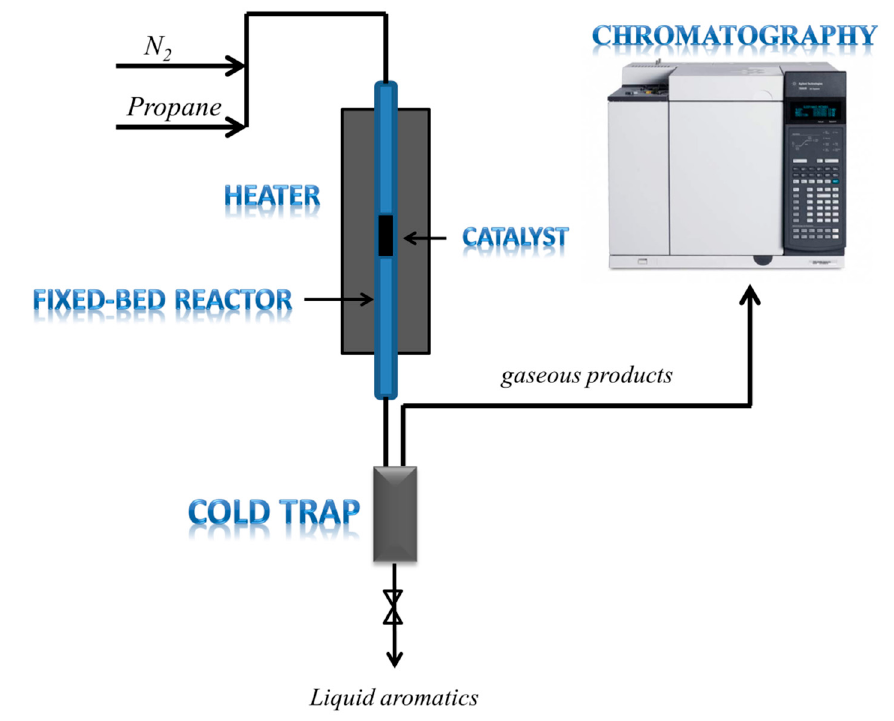
Figure 11. Schematic diagram of fixed-bed reaction process.